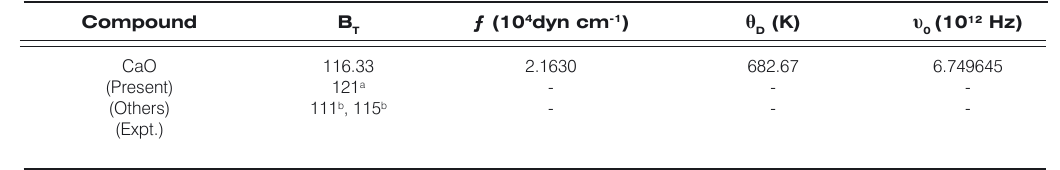
Table 4. Thermal properties of CaO at temperature T=300